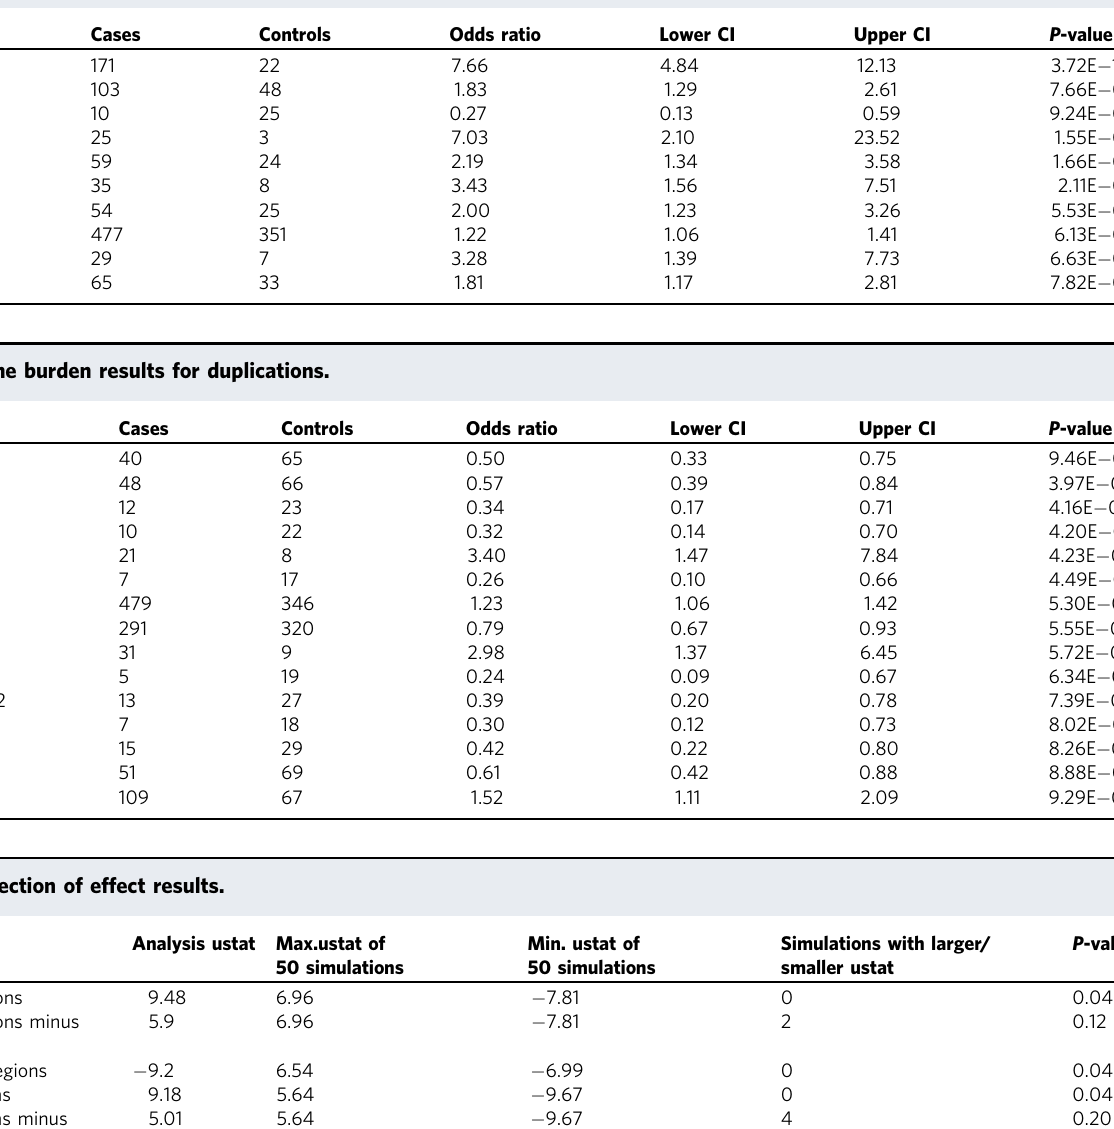
Table 4 Gene burden results for deletions.